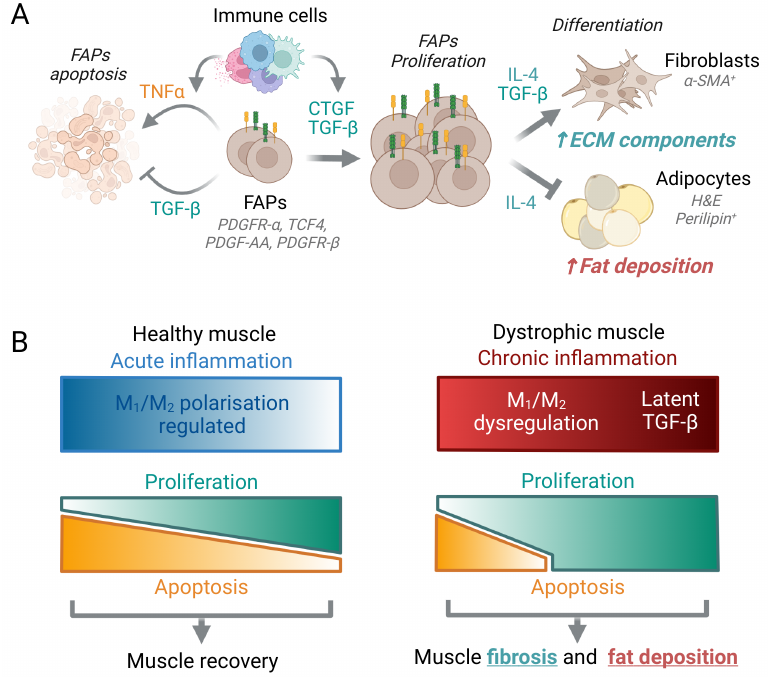
Figure 5. Regulation of connective tissue regeneration in healthy and dystrophic muscles. ( A ) Pro- liferation and differentiation of FAPs into myofibroblasts or adipocytes (markers in grey cursive letters) are regulated by pro- and antifibrotic signals released mainly by immune cells. While TNF α released by M1 macrophages induces FAP apoptosis [236], anti-inflammatory cytokines such as TGF- β and connective tissue growth factor (CTGF) promote their proliferation and differentiation into ECM-producing fibroblasts [237]. Moreover, eosinophil-produced interleukin 4 (IL-4) also contributes to FAP differentiation, and while activation of the IL-4 signalling cascade promotes mouse FAP differentiation into fibroblasts and contributes to normal connective tissue remodelling, its inhibition produces their differentiation into adipocytes and is associated with increased intramuscular fat, glucose dysregulation and muscle weakening [238,239]. ( B ) In healthy muscle, upon injury, tight regulation of the innate immune response with balanced release of profibrotic and antifibrotic factors produces the correct regeneration and maturation of damaged myofibres and parallel reconstruc- tion of the extracellular matrix (ECM). However, in patients with DMD and animal models of the disease, continuous cycles of degeneration and regeneration contribute to chronic inflammation, constant release of profibrotic TGF- β and dysregulation of the ECM component deposition, leading to substitution of muscle fibres with fibrotic and adipose